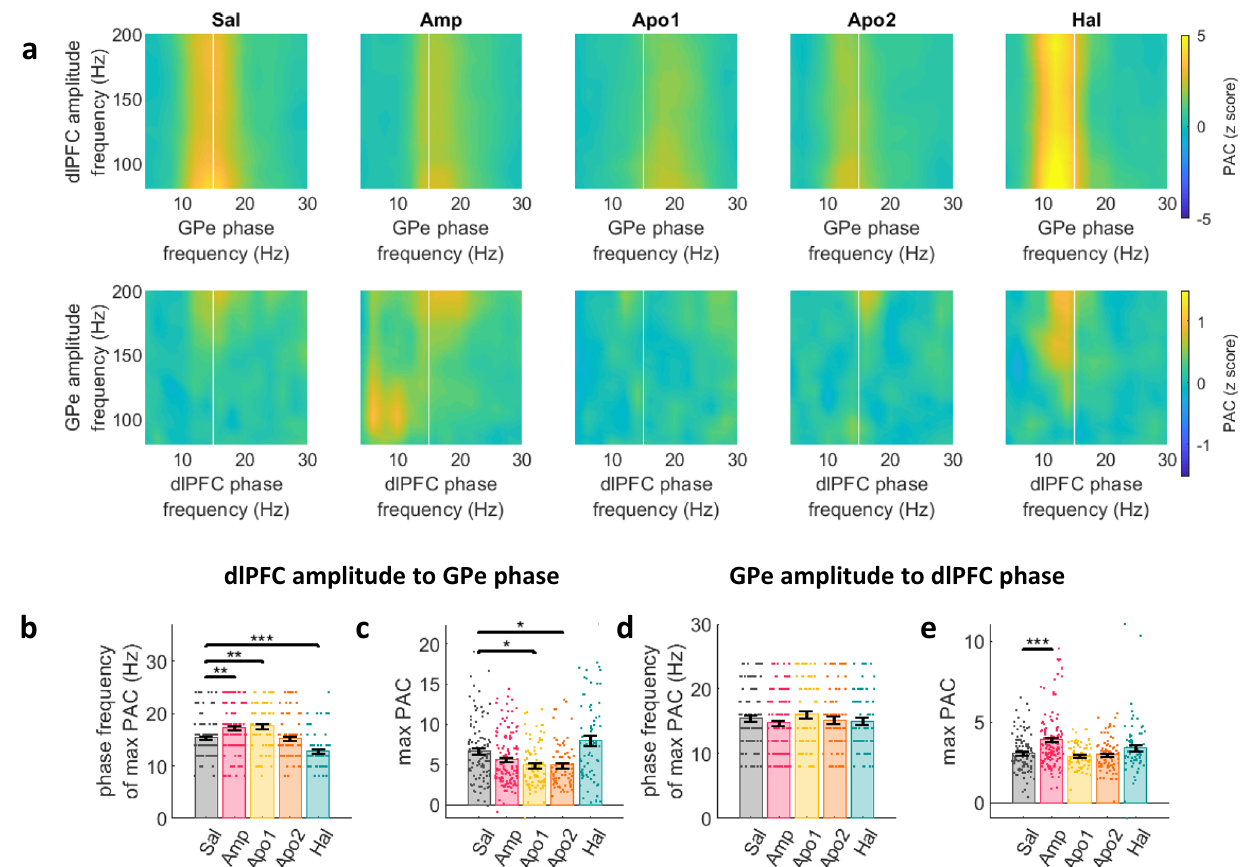
Fig. 6 Acute up- and down-modulation of dopamine tone up- and down-shifts frequency and degree of HF-beta PAC. a PAC of dlPFC HF amplitude to GPe beta phase ( N = 459 LFP pairs) and PAC of GPe HF amplitude to dlPFC beta phase ( N = 457 LFP pairs). x -axis: phase frequency, y -axis: amplitude frequency. White line marks the 15 Hz phase frequency for reference. b – e phase frequency ( b , d ) and PAC value ( c , e ) at maximum PAC (mean ± STE) for dlPFC-to-GPe ( b , c ) and GPe-to-dlPFC ( d , e ) PAC. Single points indicate electrode pairs. b , c Dopaminergic drugs modulated phase frequency ( b ; Amp: p = 0.003, Apo1: p = 0.003, Hal: 9.3e-4) and maximum PAC value ( c ; Apo1: p = 0.01, Apo2: p = 0.01) of dlPFC-to-GPe PAC ( d ) Dopaminergic drugs did not modulate phase frequency of GPe-to-dlPFC PAC. e Amphetamine increased GPe-to-dlPFC maximal PAC value ( p = 2.6e-5). Drug in fl uence